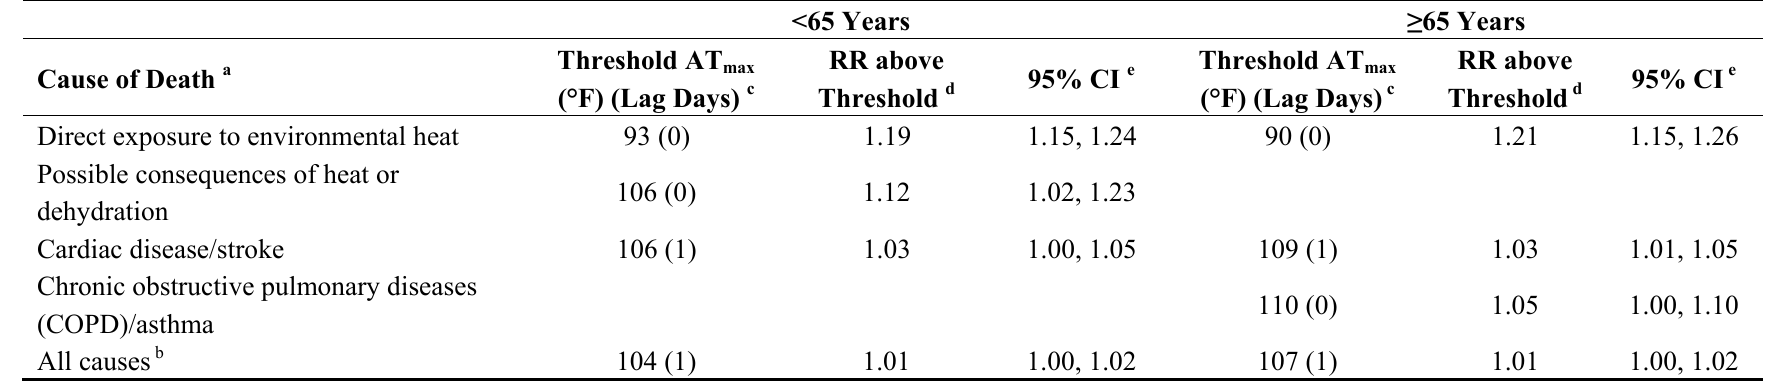
Table 3. Deaths in Maricopa County residents ages <65 years and ≥ 65 years directly caused by exposure to environmental heat and other causes potentially related to high temperatures during the months May–October for years 2000–2008.